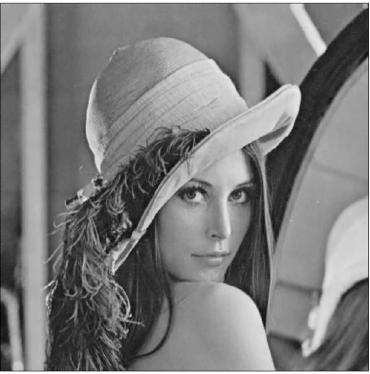
Figure 2. An example of a grayscale image with 512 × 512 resolution.